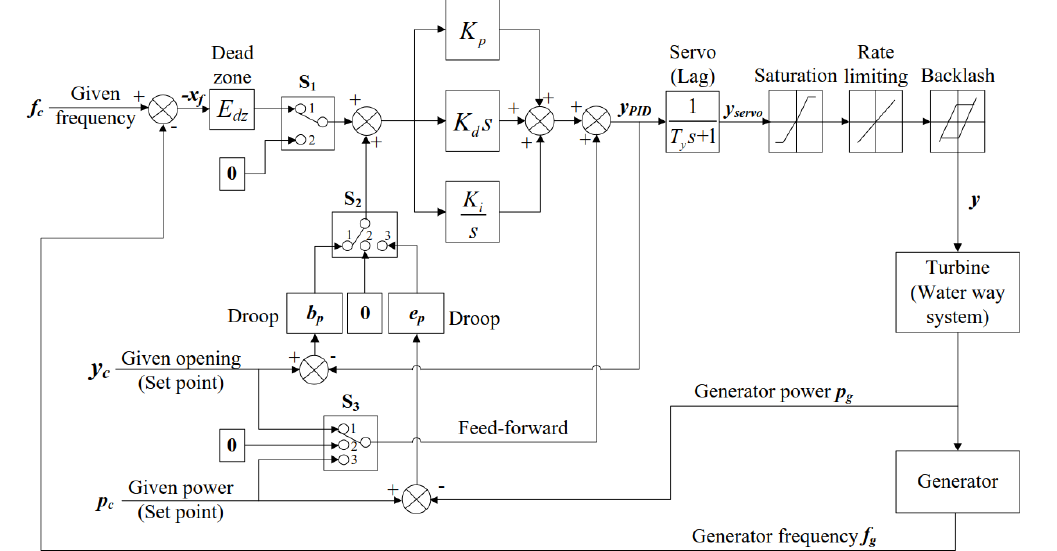
Figure 3. Governor system in